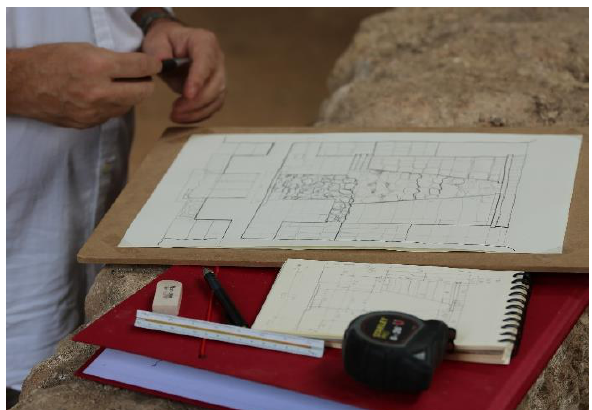
Figure 6. Traditional freehand sketching at Uxmal, Mexico. (Photo C. Vidal 2019).